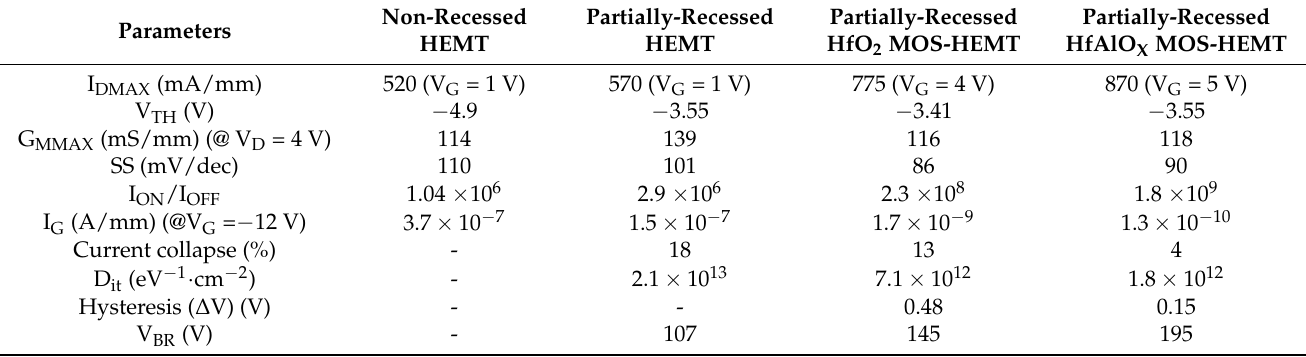
Table 1. Comparison of N 2 plasma treated Γ -gate HEMT and MOS-HEMTs and C-HEMT w/o the N 2 plasma treatment. Parameters